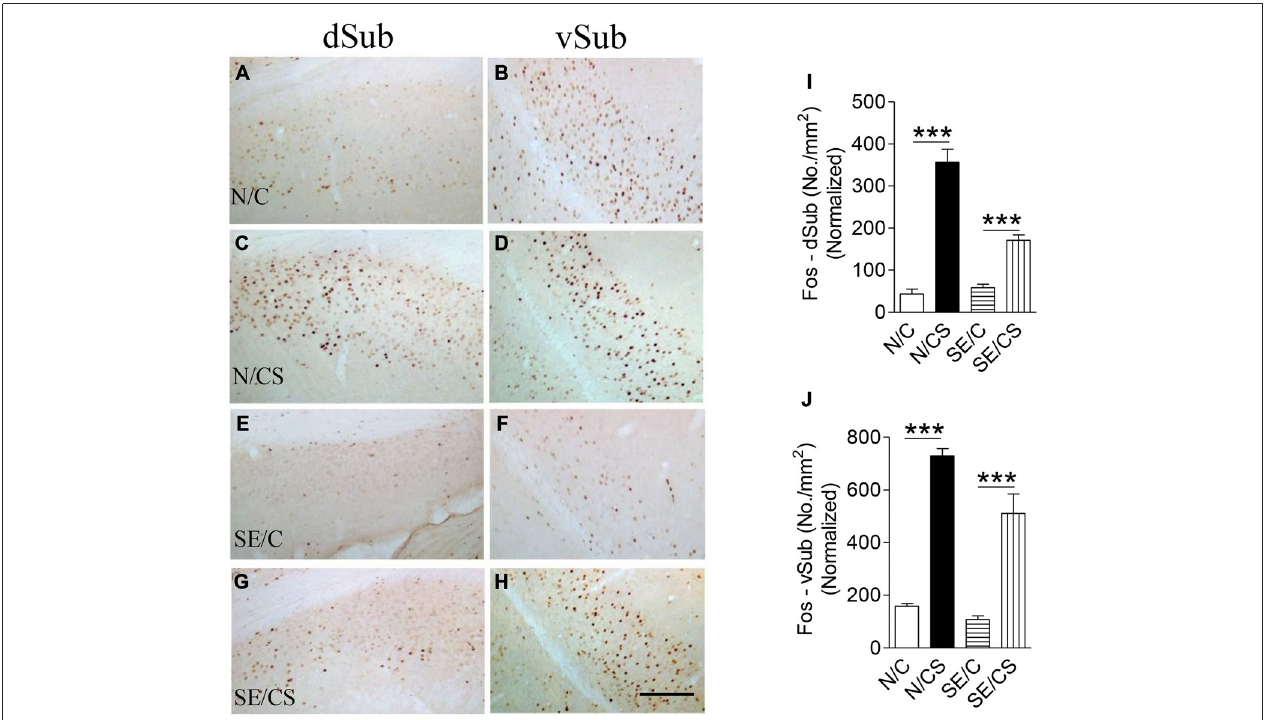
FIGURE 5 | Increased expression of c-Fos at the vSub upon contextual learning and memory test. Representative images show c-Fos immunopositive neurons in the dorsal (dSub) (A,C,E,G) and ventral (vSub) (B,D,F,H) subiculum in the different groups as indicated. Graphs (I,J) show quantification of c-Fos-immunopositive neurons per area (mm 2 ) in dSub (I) or vSub (J) normalized with neuronal loss in the SE2m group (ANOVA post hoc test, ∗∗∗ p < 0.001). Scale bar = 100 µ m in (H) applies to (A–G)